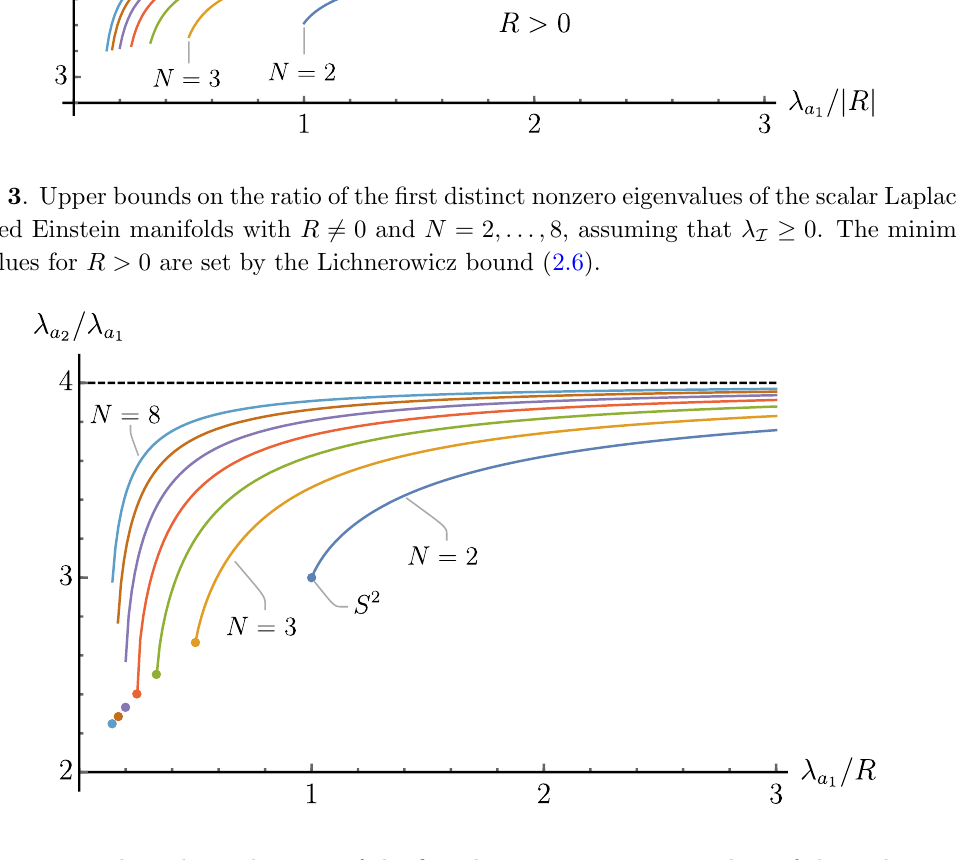
satis(cid:12)es the inequality I